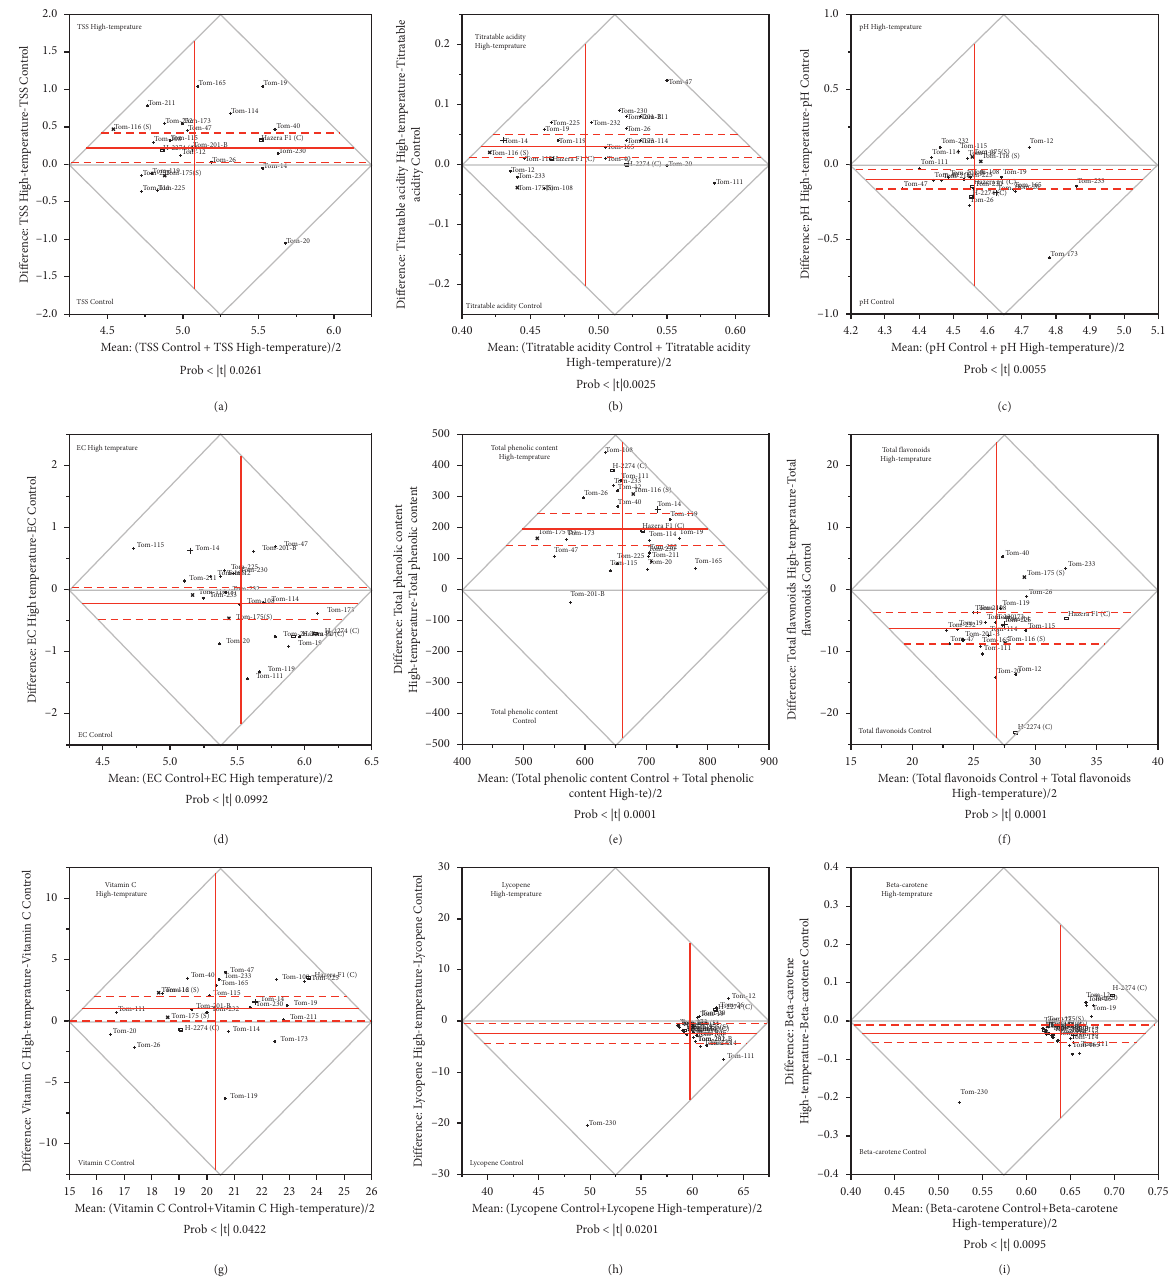
Figure 3: Comparison of high-temperature stress by paired t -test: total soluble solids: (a) titratable acidity, (b) pH, (c) EC, (d) total phenols, (e) total flavonoid, (f) vitamin C, (g) lycopene, (h) beta-carotene, and (i) content. +tolerant, × susceptible □